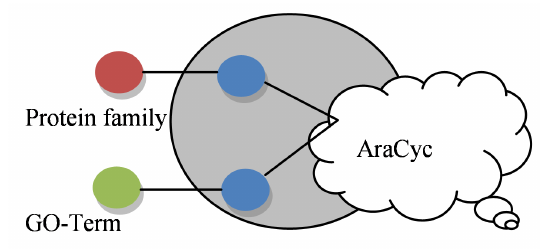
Figure 4: After the “collapse filter” was applied the proteins (blue) were merged in to one concept.